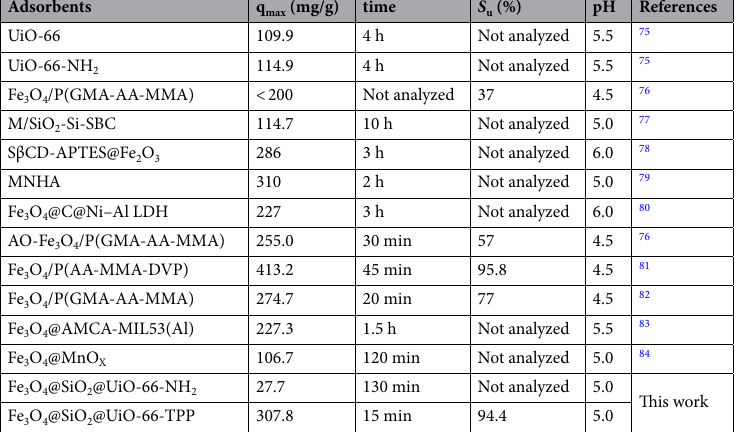
Table 4. Comparison of the maximum adsorption capacity of Fe 3 O 4 @SiO 2 @UiO-66-TPP NPs with other magnetic